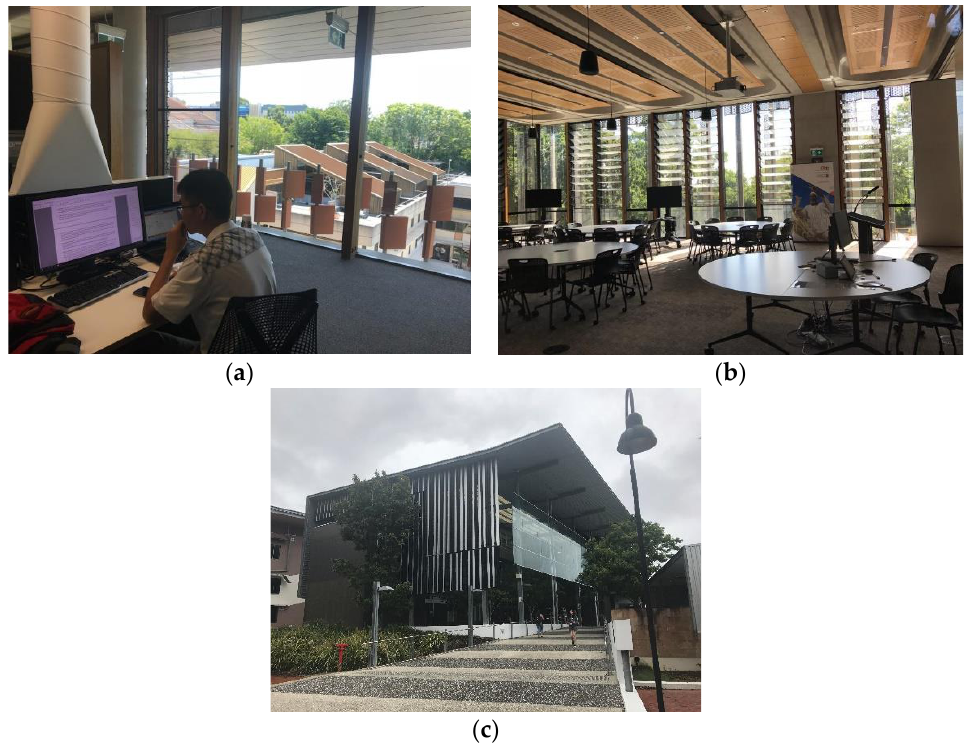
Figure 1. Three example buildings in the green building group sample. ( a , b , c ) are fully automated, semi-automated, and manual mixed-mode buildings, respectively.